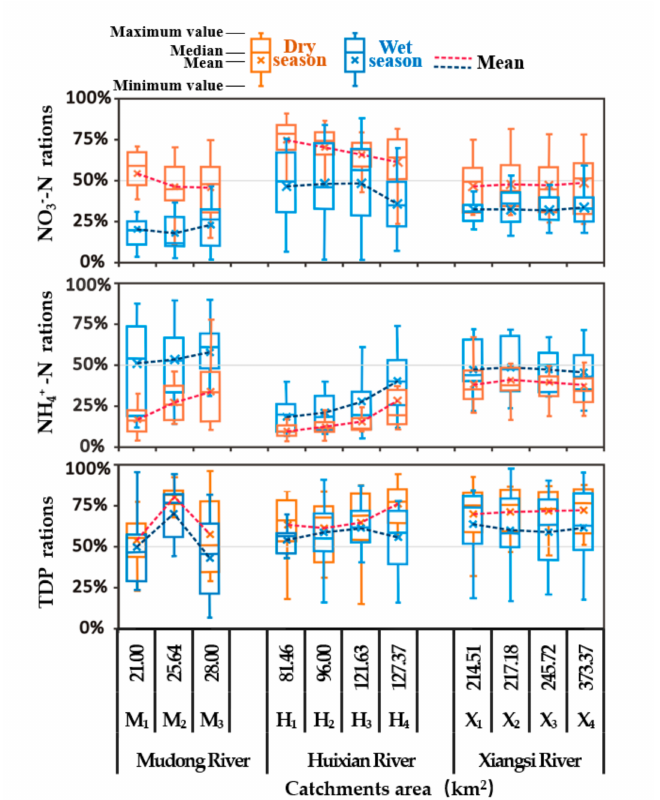
− –N and NH + –N to TN and of TDP to TP calculated for the sum of 3 4